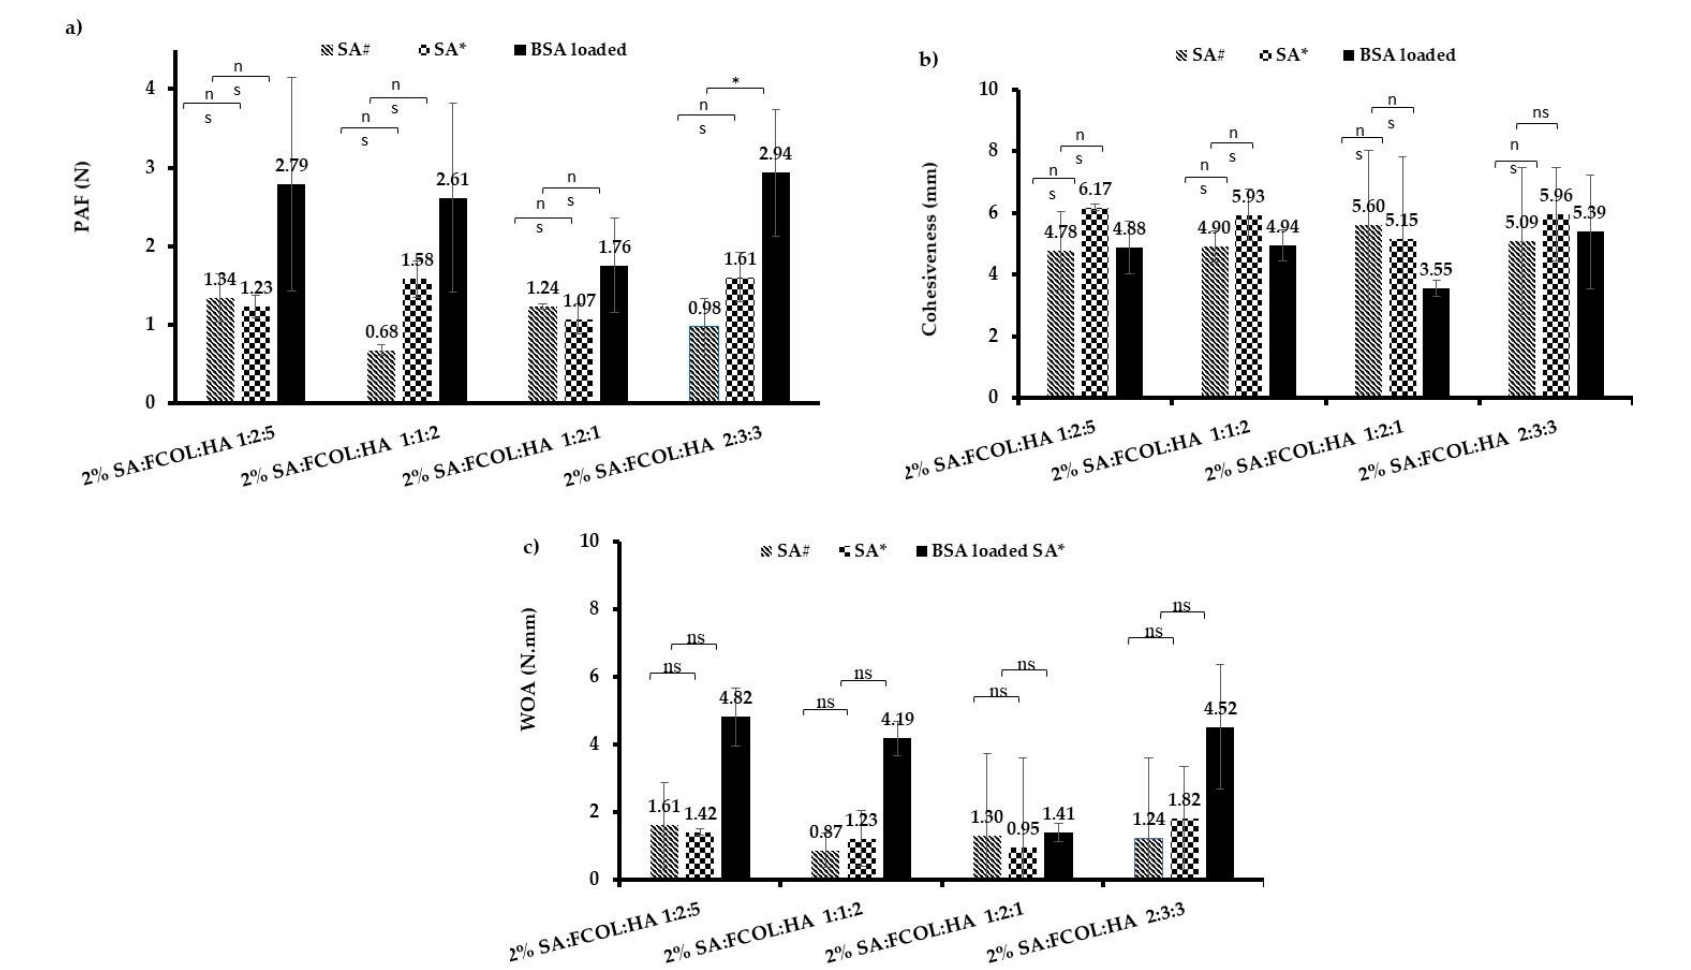
Figure 6. Adhesive profiles of blank 2% SA#:FCOL:HA, blank 2% SA*:FCOL:HA, BSA loaded SA*:FCOL:HA showing: ( a ) peak adhesive force; ( b ) cohesiveness; ( c ) work of adhesion. Data are shown as mean ± standard deviation ( n = 3). The (*) represents p < 0.05 and ns denotes p > 0.05.